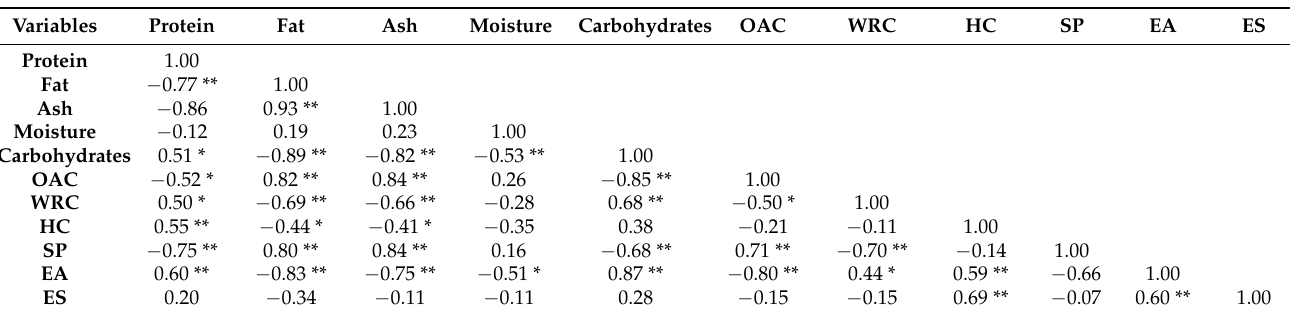
Table 4. Pearson correlation